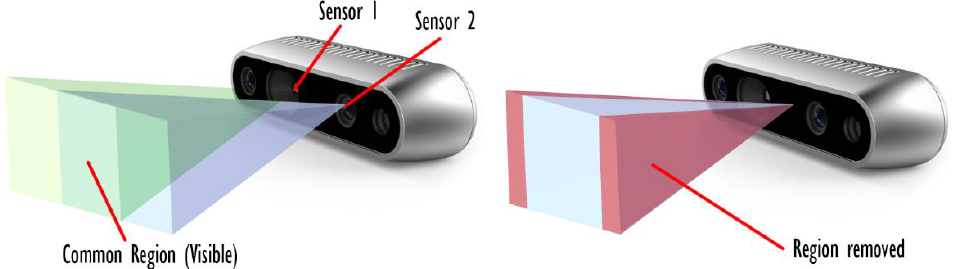
Figure 6. Modelling of the Field of View (FOV) of triangulation-based sensors.